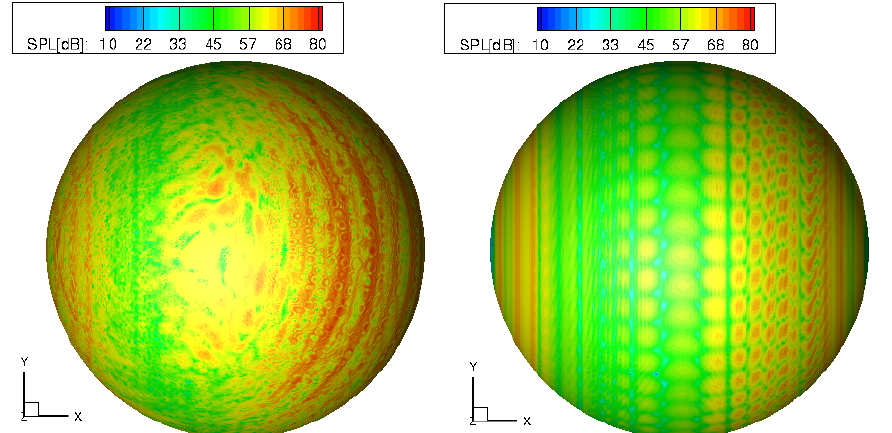
Figure 16. Scattered noise (BEM, left ) results for frequency 2000 Hz, BLI case, compared to Direct noise field ( right ).